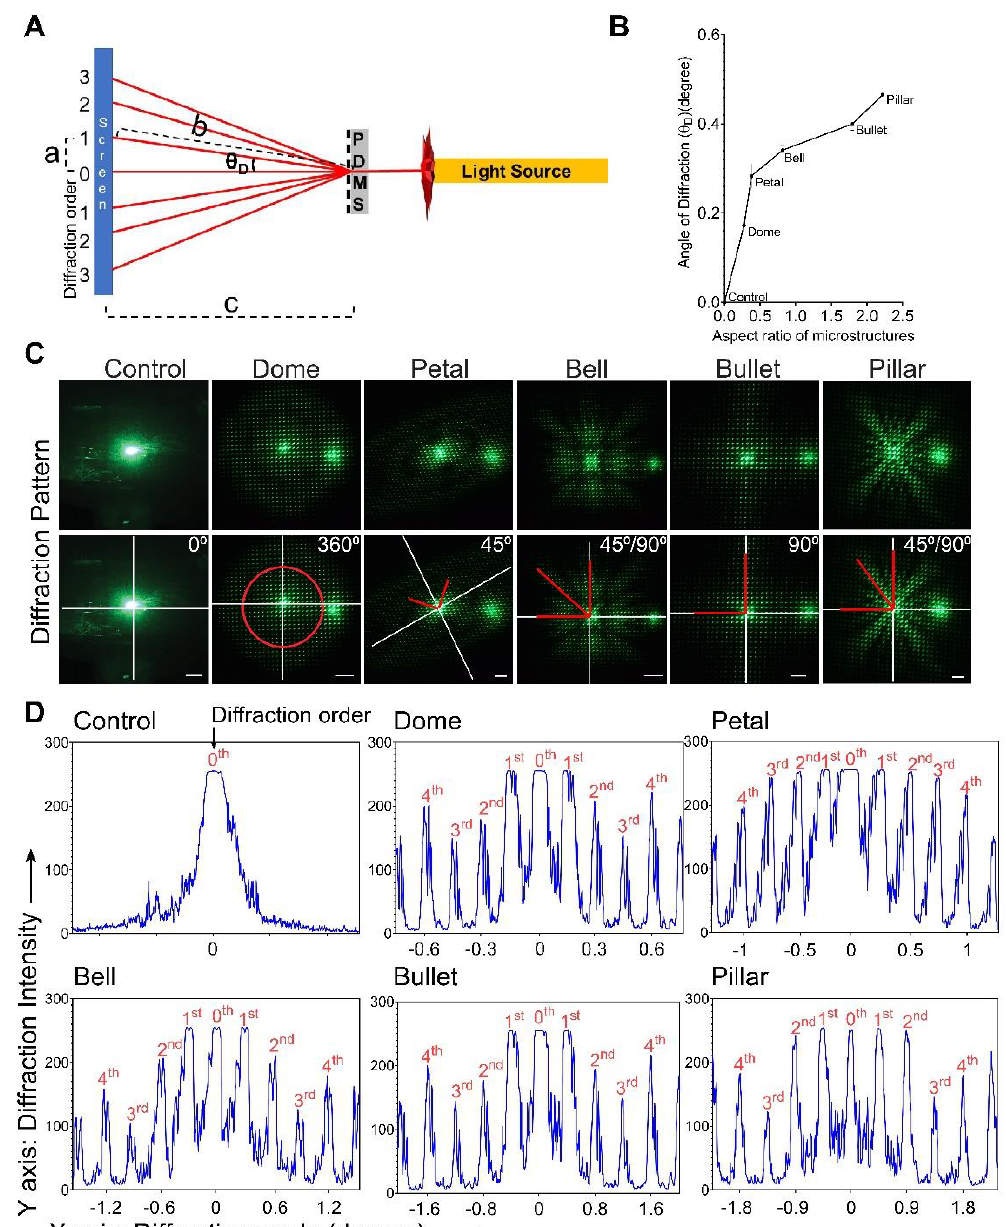
Figure 5. Characterization of optical diffraction of a monochromatic wavelength passing through the MSAs. ( A ) Schematic of the optical arrangement to determine diffraction angle. “a” is the distance between 0th (un-diffracted light) and 1st (diffracted light) order of diffractions. “c” is the distance between the MSA and the screen. “b” was calculated based on a and c values. Using these values, the 1st order angle of diffraction, θ D , was calculated as the angle between the un-diffracted and first-order diffracted light. ( B ) The angle of diffraction, θ D , as a function of the MSA aspect ratio. ( C ) Top row: Diffraction pattern of the monochromatic light through the DEL-MSA grating. Note that the brightest intensity observed on the right side in the diffraction images was an artifact that occurred during image capturing and was not considered for any calculations or conclusions. Bottom row: The angle of diffraction along the brightest intensity path was notated: white lines indicate the x- and y-axis passing through the 0th order of diffraction, which was the reference to calculate the diffraction pattern angle (indicated by the red lines). The numbers indicate the brightest light diffraction angle. ( D ) Intensity profile of the diffraction pattern (up to 4th order) as a function of diffraction angle. Error bars: ( B ) STDEV. Scale bar: ( C ) 3 cm.